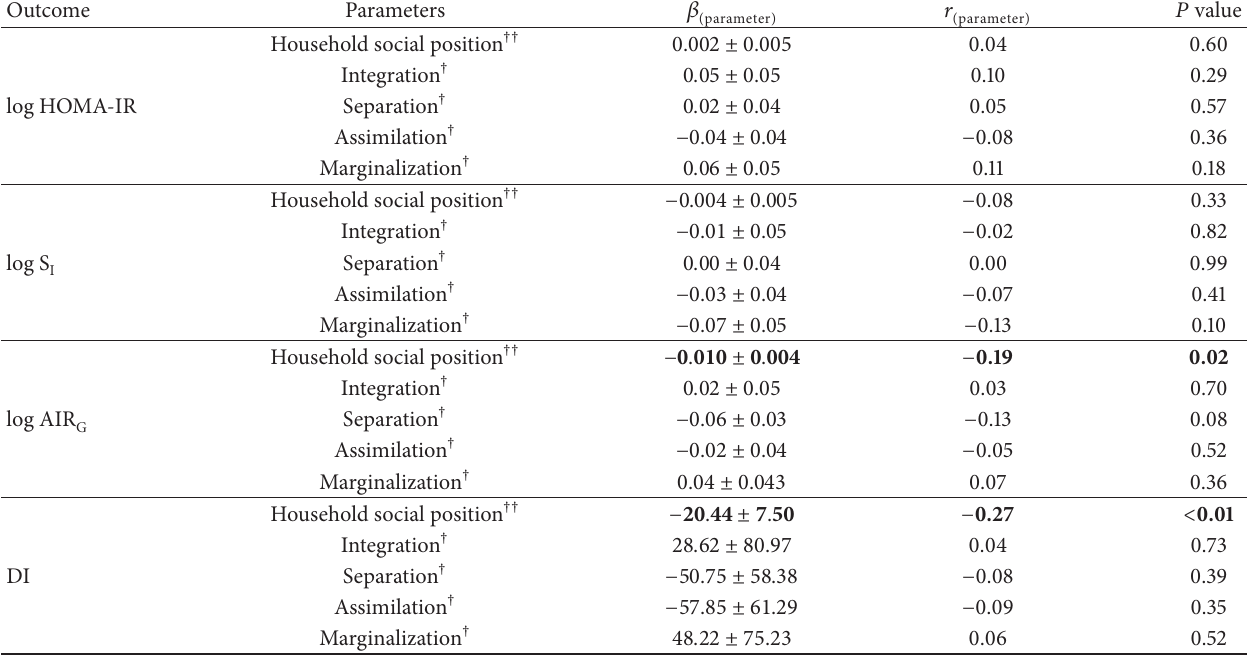
Table 4: Results of multiple regression analysis for Latino-American children and adolescents ( 𝑛 = 102 ).